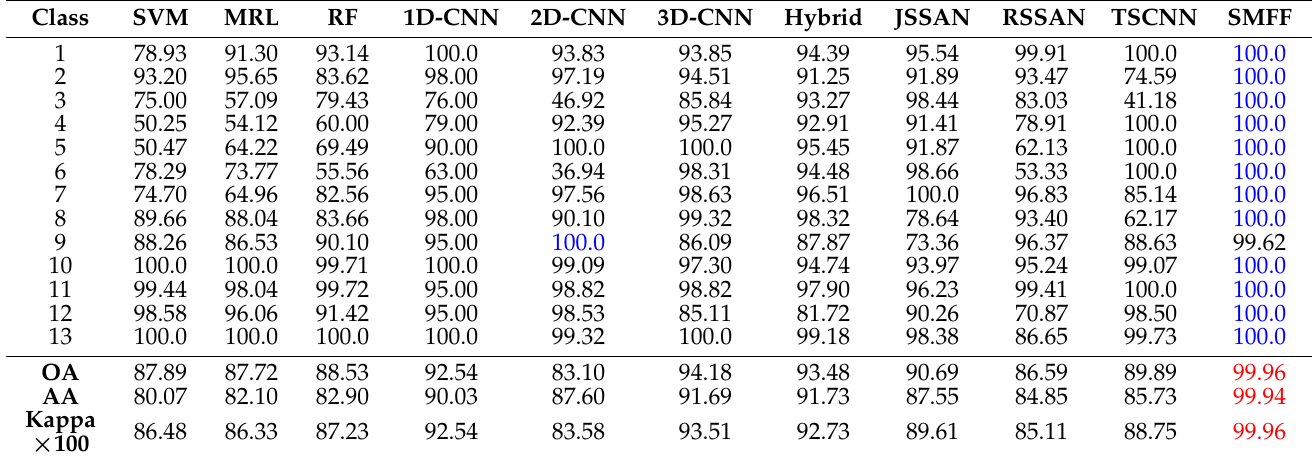
Table 7. Classification results of different methods for the KSC